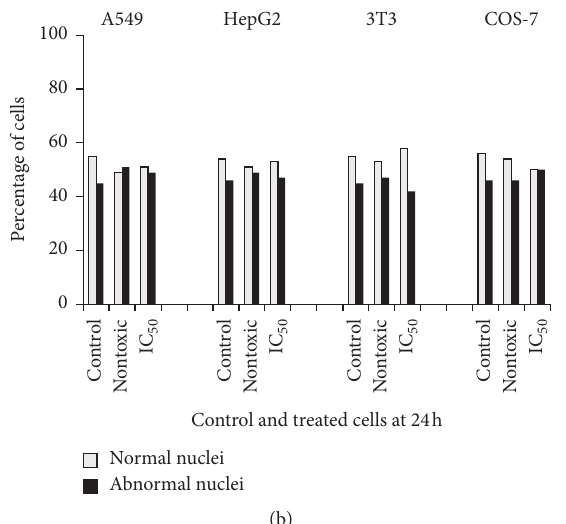
Figure 3: (a) Nuclear features of cells as revealed in Hoechst staining. (b) Percentage of cells with normal and abnormal nuclei. Data are expressed as average of three independent observations.